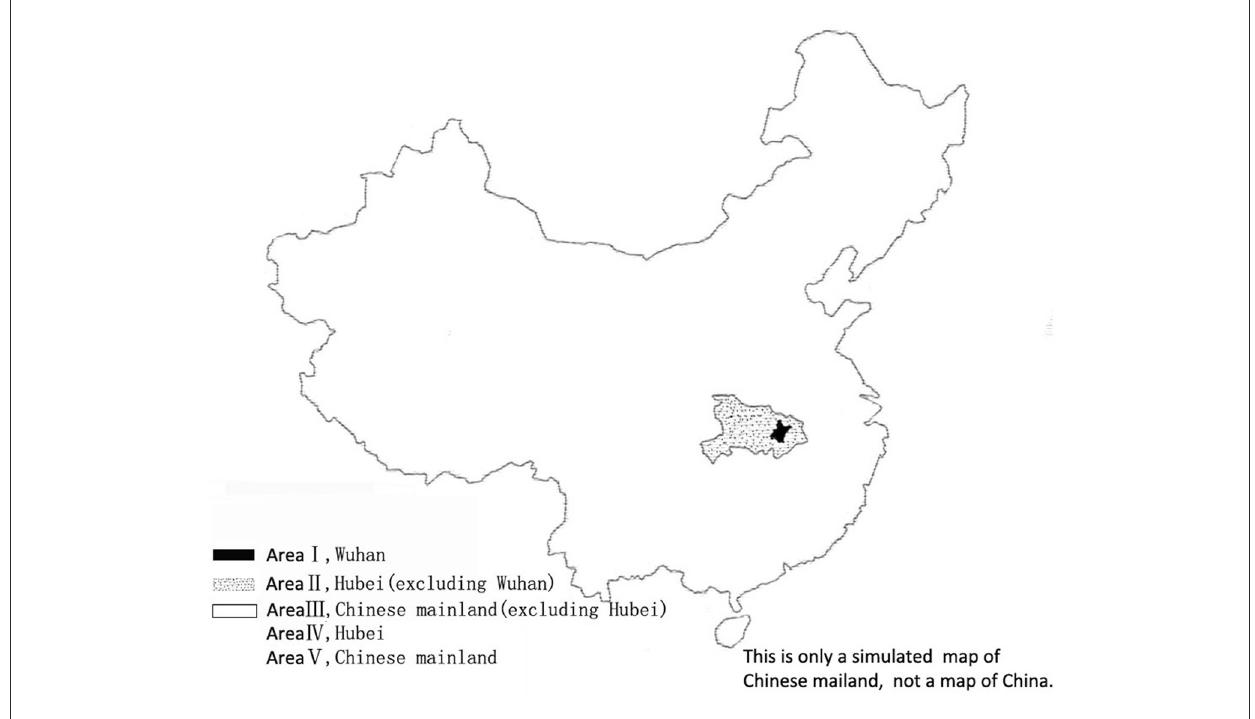
FIGURE1 Division of COVID-19 epidemic areas in Chinese